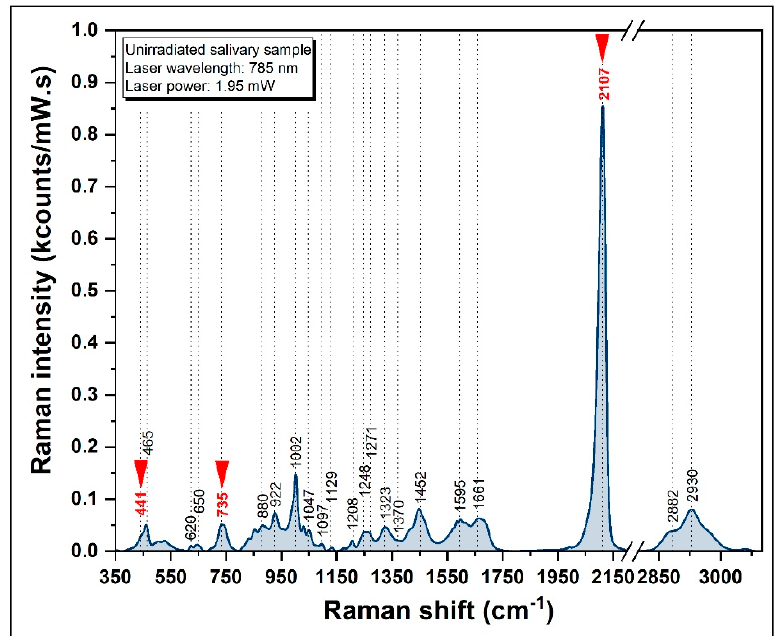
Figure 6. A typical SER spectrum of saliva ( λ = 785 nm). The red arrows indicate the thiocyanate specific vibrational bands.